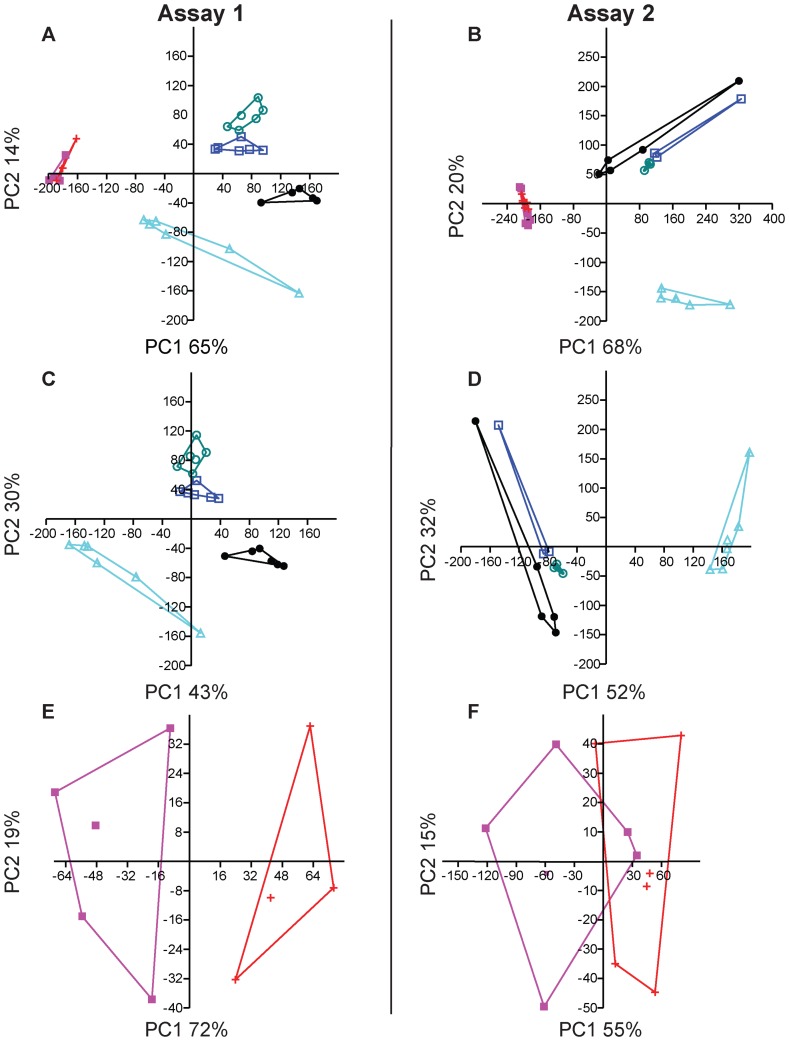
Influence of different settlement-inducing cues and exposure times on gene expression of Acropora millepora larvae.PCA score plots of the % difference in gene expression compared to the control, presented with convex hulls highlighting groupings and showing PC1 and PC2, for A) J010-E 1–12 hpi and HOorg/aq, Assay 1, B) J010-E 1–12 hpi and HOorg/aq, Assay 2, C) J010-E 1–12 hpi, Assay 1, D) J010-E 1–12 hpi, Assay 2, E) HOorg/aq, Assay 1 and F) HOorg/aq, Assay 2. Time points for J010-E are represented by: 1 hpi = black full circle, 2 hpi = blue empty square, 3 hpi = green empty circle and 12 hpi = cyan empty triangle. CCA-derived cues are represented by: HOorg = pink full square and HOaq = red cross.